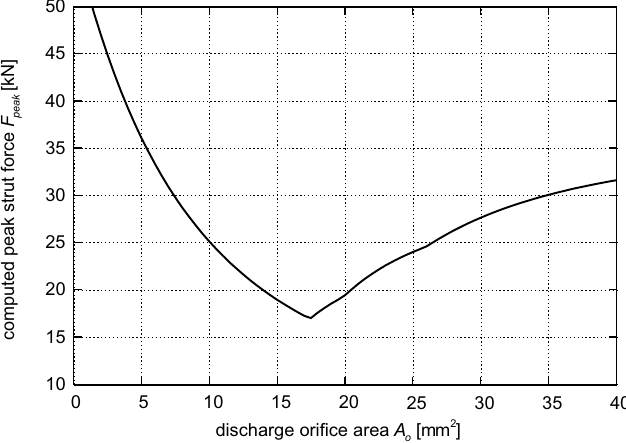
Fig. 6. Passive LG: Computed dependence of the peak strut force F peak on the discharge orifice area A o at the highest-energy design landing scenario ( m = 422 kg and v 0 = 2 . 93 m / s ). F max = 17 021 N , A PLG o = 17 . 43 mm 2